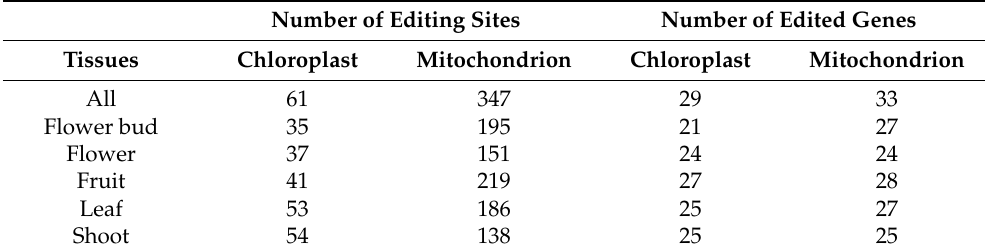
Figure 5. Synteny analysis of MORF genes in kiwifruit. ( a ) Synteny analysis of MORF genes between kiwifruit and A. thaliana . Gray lines in the background indicate the collinear blocks between different species, whereas the orange lines highlight the syntenic MORF gene pairs. ( b ) Interchromosomal relationships of MORF genes in kiwifruit. Gray lines indicate all synteny blocks within the kiwifruit genome, and the red lines indicate synteny blocks where duplicated MORF gene pairs were. Table 2. Distribution of RNA editing sites among different tissues in chloroplasts and mitochondria of